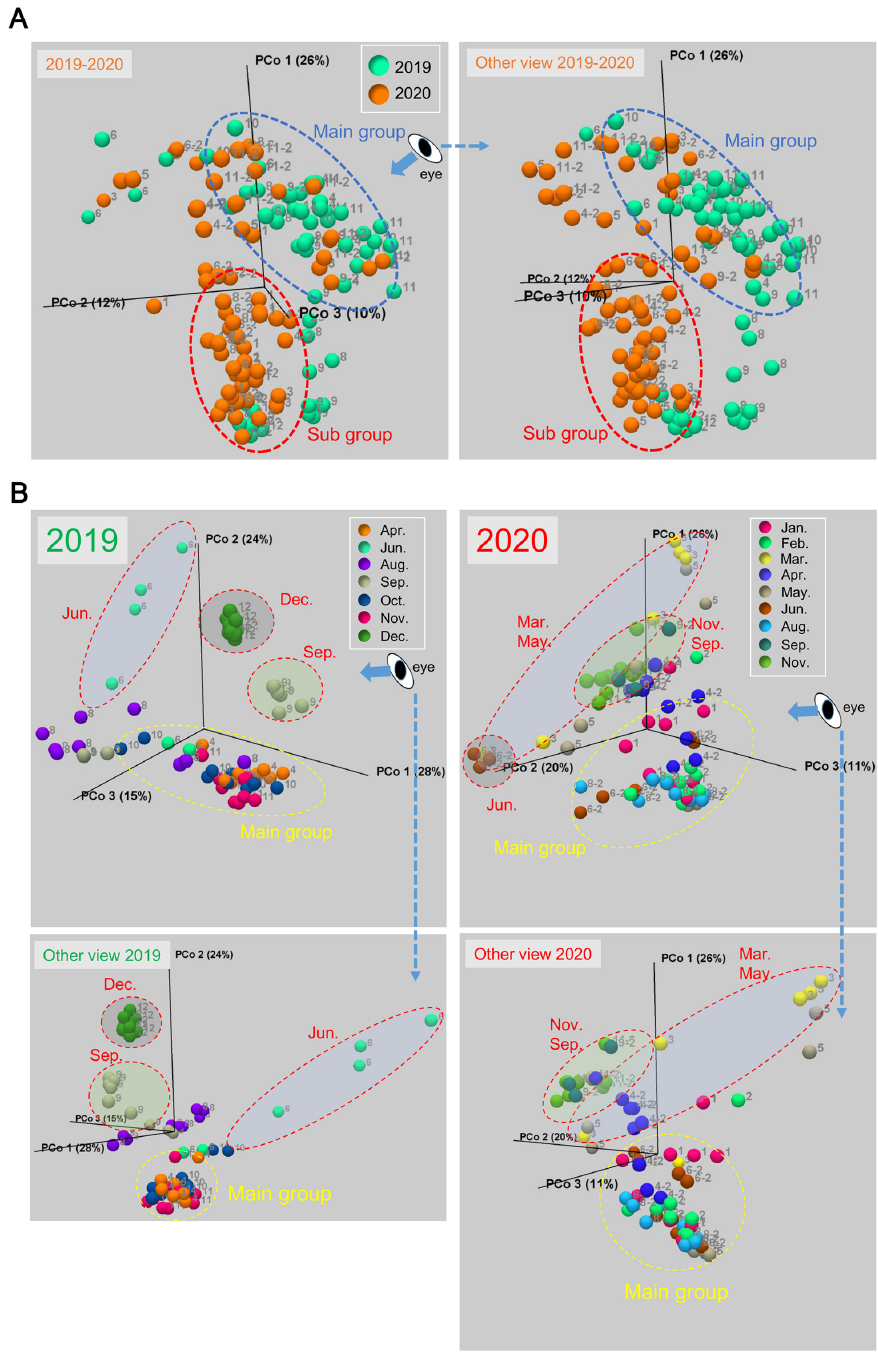
Figure 3. Beta-diversity of the skin mucus bacterial flora of rainbow trout in flow-through aquaculture. ( A ) For β -diversity, the weighted UniFrac distance was calculated using all data from both years (2019 and 2020), and the data are visualized in a 3D-PCoA plot. The blue dotted circles repre- sent the main group of the skin mucus bacterial flora, and the red dotted circles represent the sub- group. The number next to each dot indicates the sampling month; the other view from the indicated direction marked “eye” and with arrows is also shown. ( B ) The β -diversity was calculated using the data for each year separately. The yellow dotted circles represent the main group of the flora, and the red dotted circles represent groups that clearly differed from the main group. The number next to each dots indicates the sampling month; the other side view from indicated direction is also shown.